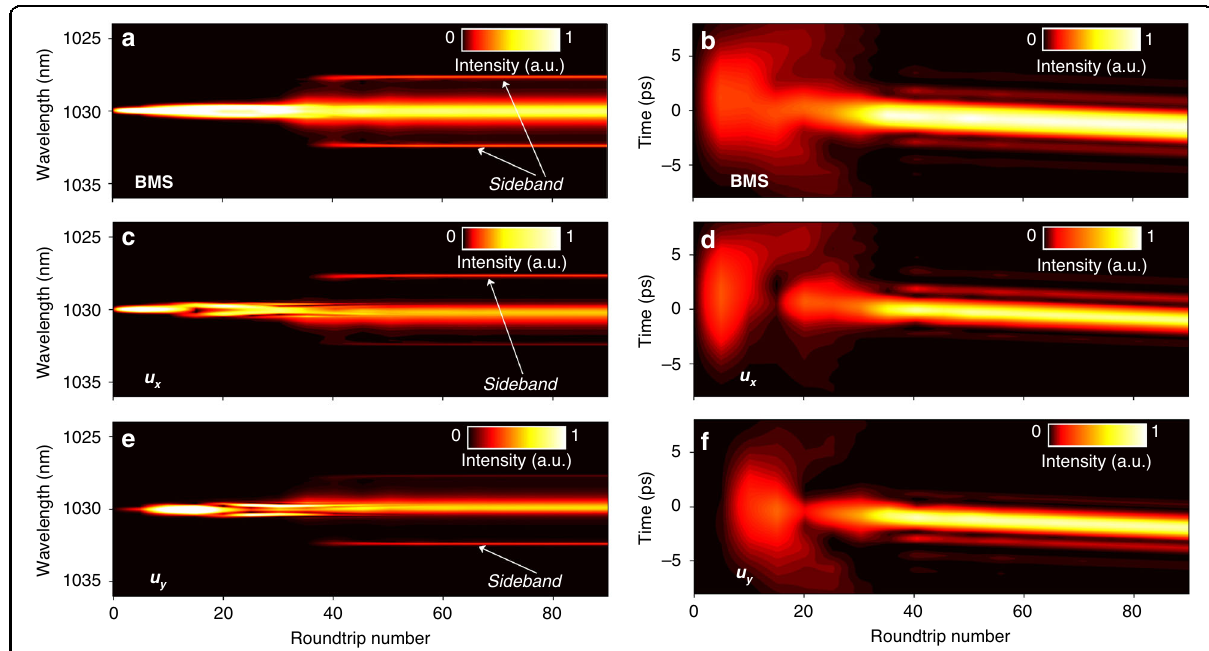
Fig. 4 Establishment process of BMS for PMF length of 1.5 m and θ of 0.25 π . Simulated spectral and temporal evolutions of ( a , b ) BMS, ( c , d ) u x component, and ( e , f ) u y